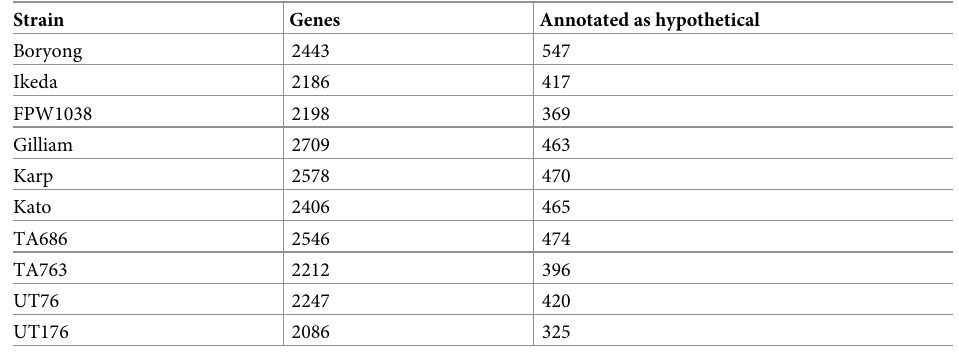
Table 2. Predicted gene numbers in different strains of O . tsutsugamushi . Strain Genes Annotated as hypothetical 2443